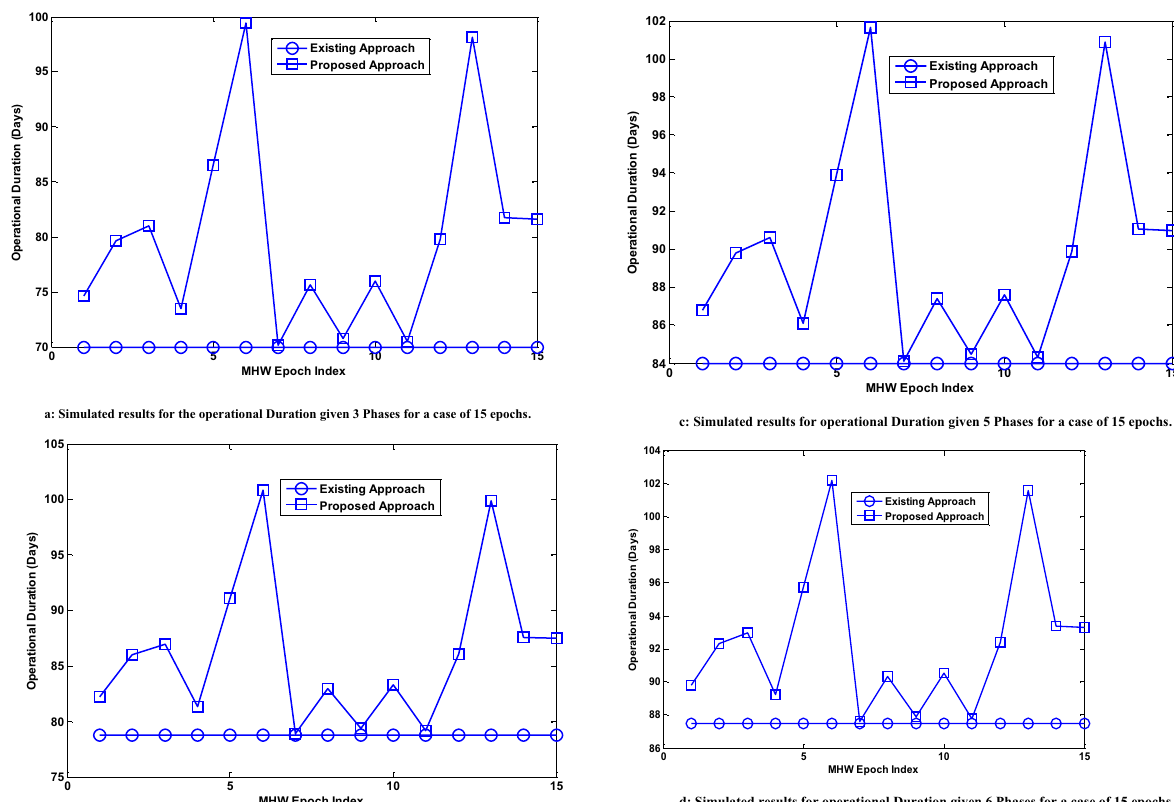
a: Simulated results for the operational Duration given 3 Phases for a case of 15 epochs.